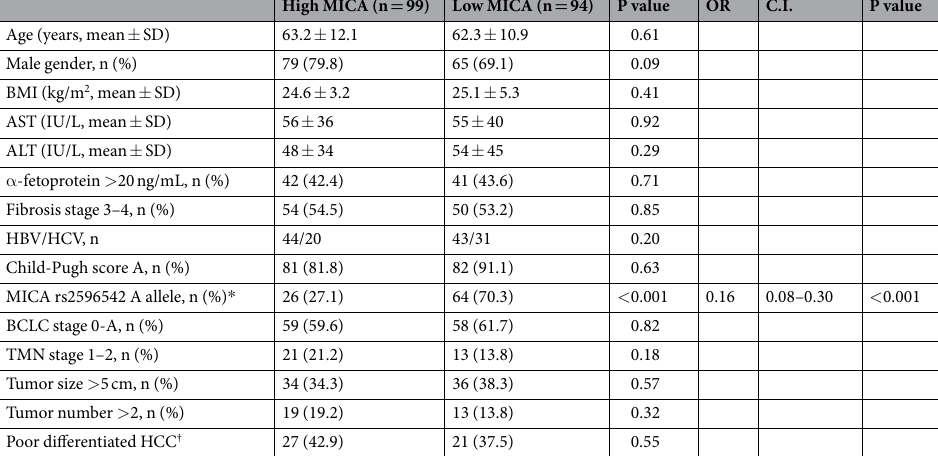
Table 3. Factors associated with high MICA expression in the cancer. Note: high MICA expression: > 30%. MICA: membrane MHC class I chain-related A. BMI: body mass index. AST: aspartate aminotransferase. ALT: alanine aminotransferase. HCC: hepatocellular carcinoma. HBV: hepatitis B virus. HCV: hepatitis C virus. BCLC: Barcelona Clinic Liver Cancer. * 6 patients had indeterminate single nucleotide polymorphism. † Data available in 119 patients. OR: odds ratio. CI: confidence intervals.